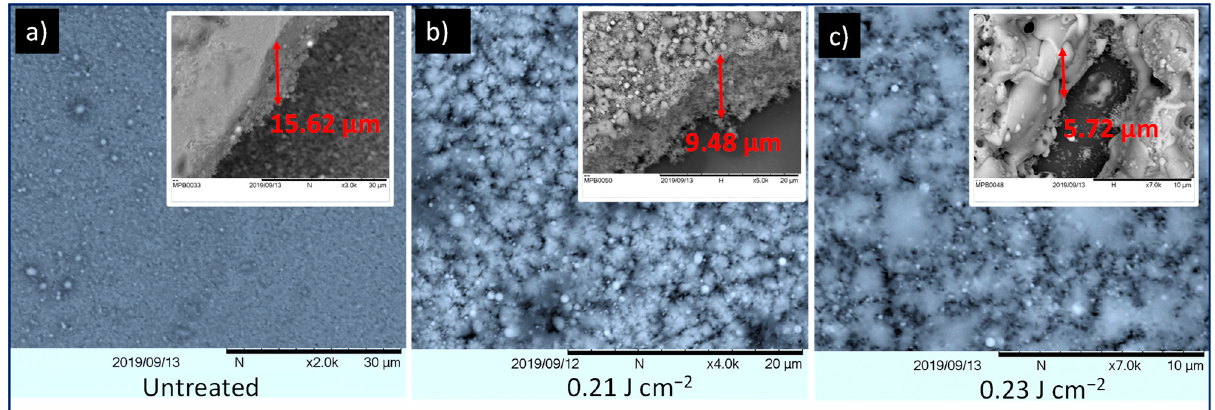
Figure 2. SEM images of ( a ) untreated screen-printed ZnO film, and laser-treated at ( b ) 0.21 J cm –2 and ( c ) 0.23 J cm –2 . Inset: side view of untreated and treated samples.